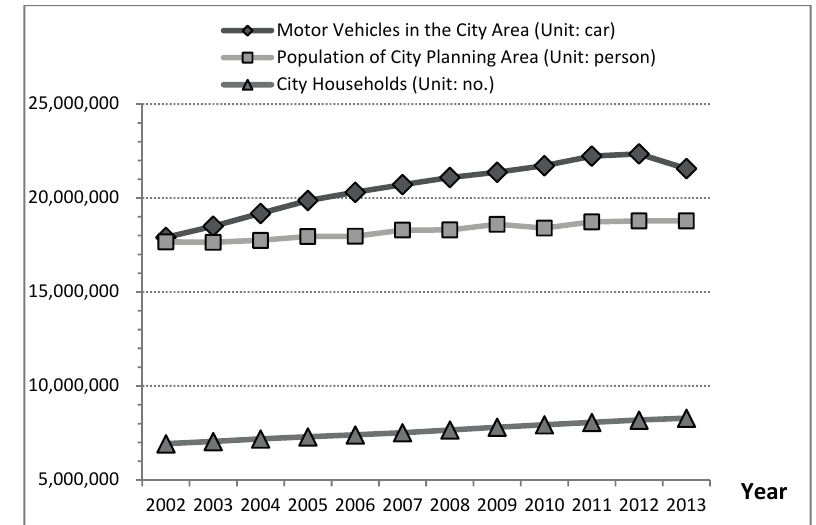
Figure 8. Trends for motor vehicles in the city area, population of city planning area, and city households, Taiwan’s cities, 2002 to 2013.